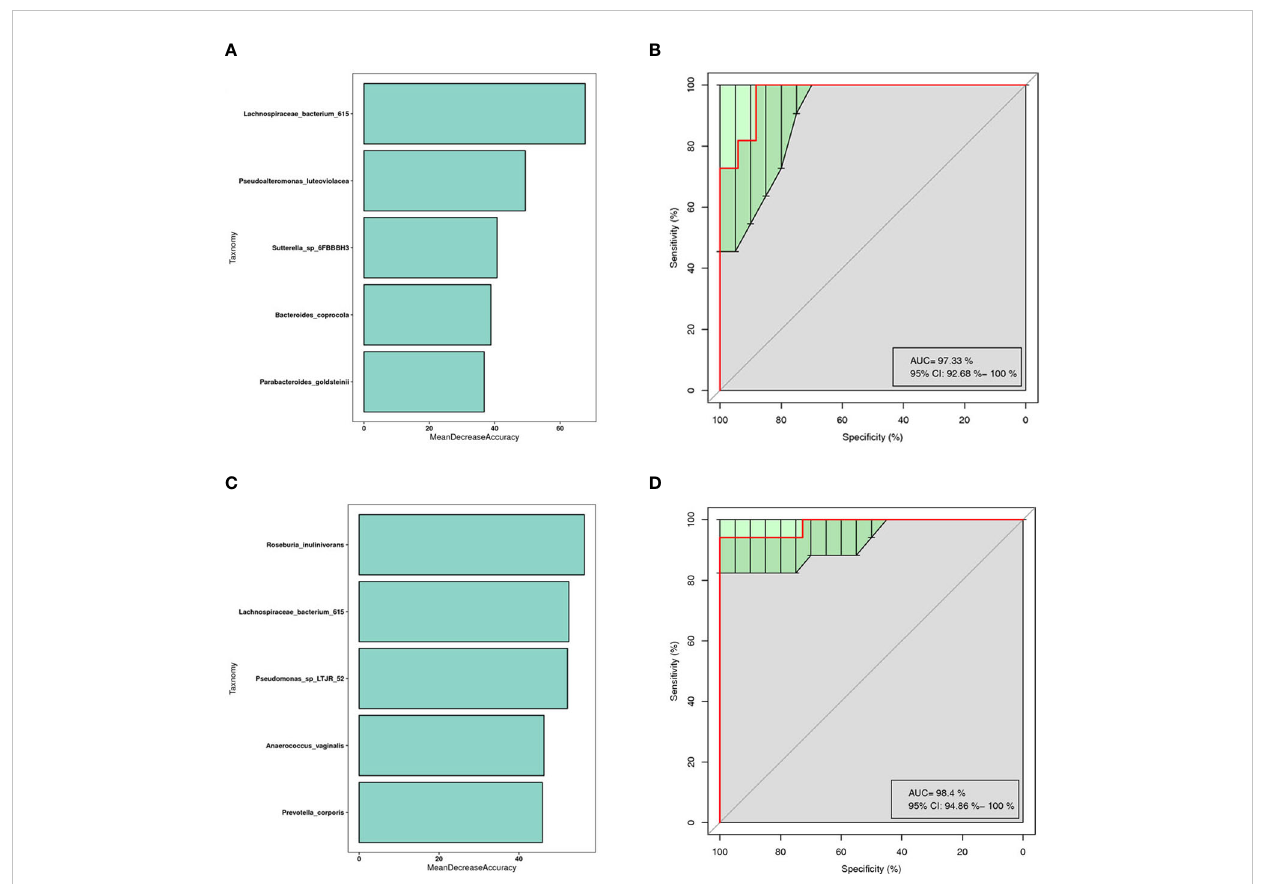
FIGURE 6 Prediction model of the airway microbiota for AR status based on the species-level relative abundances using random forests.AR (A) and nAR (C) group of variable importance ranking plots, MeanDecreeAccuracy measures the degree to which the predictive accuracy of the random forest is reduced by changing the values of the variables to random numbers. Higher values indicate more important variables. ROC curves of the AR (B) and nAR (D) model using 5 discriminatory